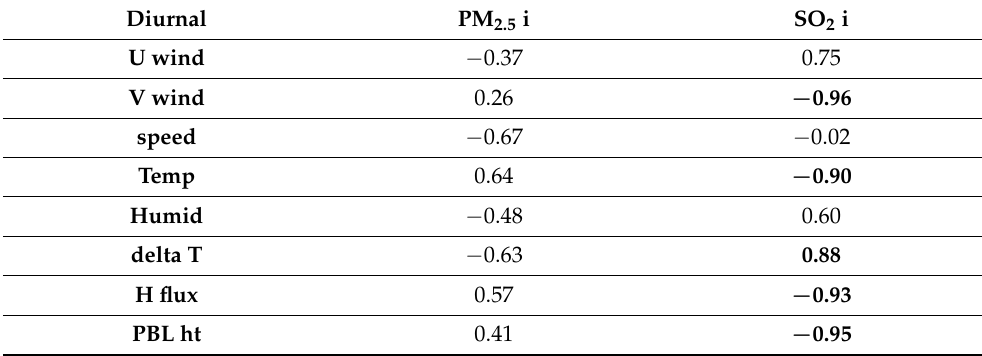
Table 5. Simultaneous pair-wise cross-correlation of surface air constituents and ERA5 1000–850 hPa meteorology variables over the Durban-area: winter mean diurnal cycle (2011–2015 N =